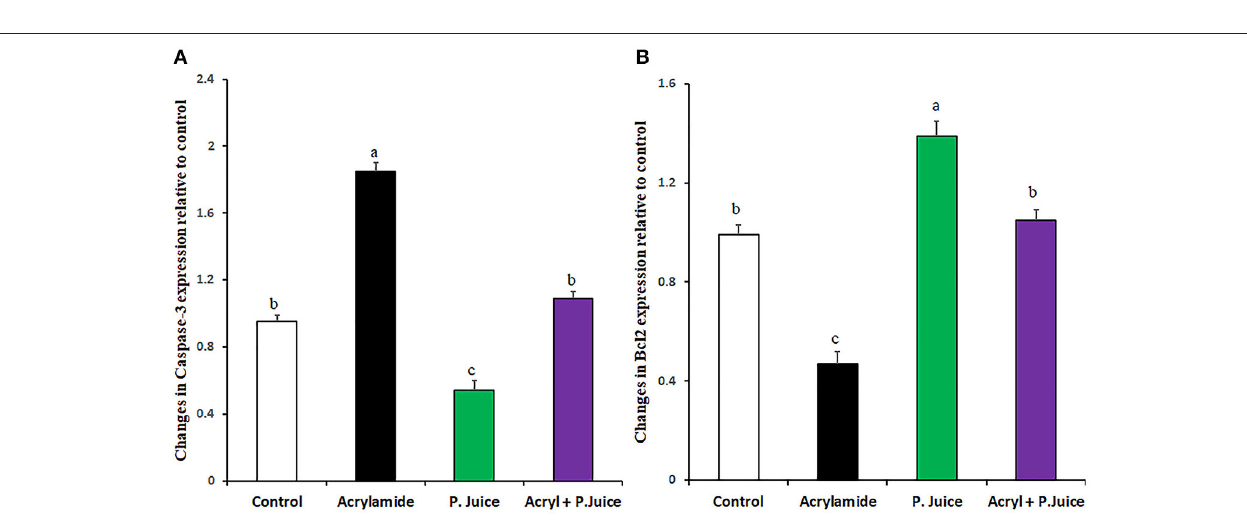
FIGURE 4 | Gene expression of the apoptotic Caspase-3 (A) and the antiapoptotic Bcl2 (B) genes in response to ACR and the TPJ in rat liver. Values are expressed as means ± SE. Means with different letters are significant ( p <